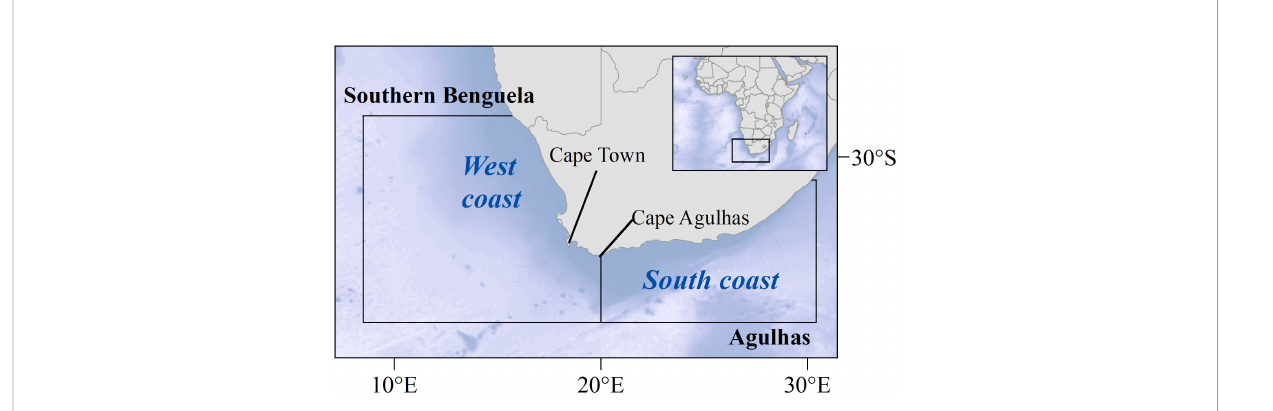
FIGURE 1 The study area focuses on the two oceanographic subsystems off South Africa that have different environmental regimes: namely the Southern Benguela upwelling ecosystem (hereafter, Southern Benguela) off the west coast, and the Agulhas Bank System (Agulhas) off the south